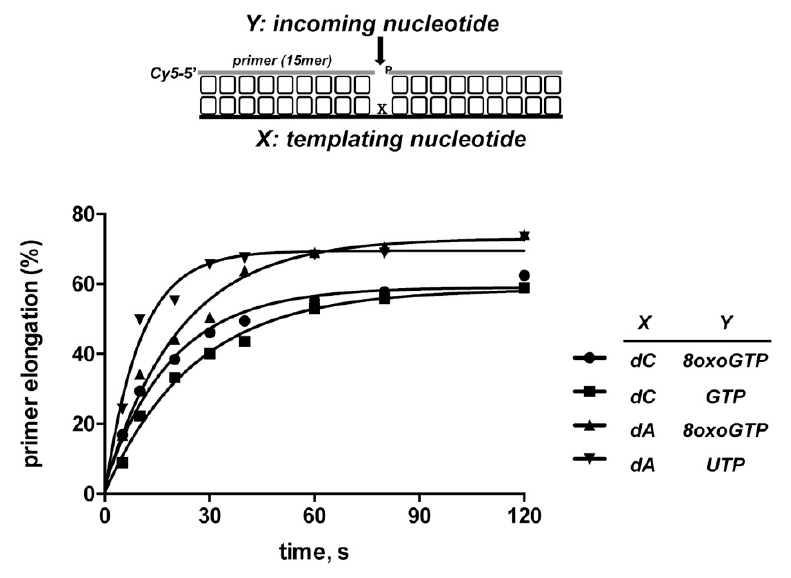
Figure 10. Kinetic measurement of 8oxoGMP incorporation by Pa- PolDom. The assay was performed as described in Materials and Methods. Insertion of the indicated nucleotide was examined as a function of the incubation time, and the rate of nucleotide incorporation was determined under single-turnover conditions by incubating 5 nM of the indicated gapped molecule (depicted in top of the figure), 40 nM of of either 8oxo GTP , GTP or UTP and 20 nM Pa -PolDom. Time course data were analyzed using a Typhoon 9410 scanner (GE Healthcare) and fitted to an exponential equation by using nonlinear least squares methods to determine the reaction rate ( k obs ).